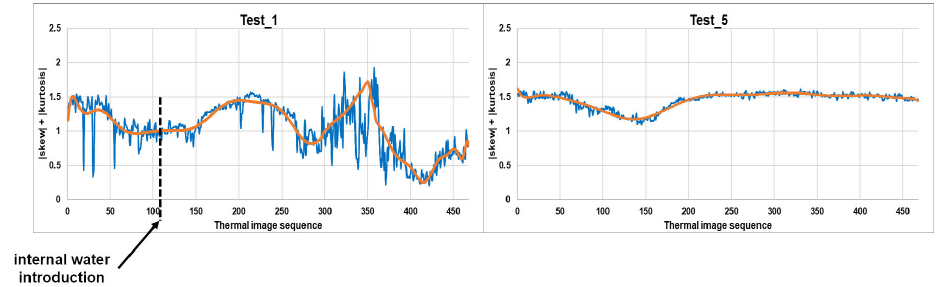
Figure 5. Evolution of the skew and kurtosis summation in Test_1 and Test_5. Before (blue line) and after (orange line) SG smoothing filter application.